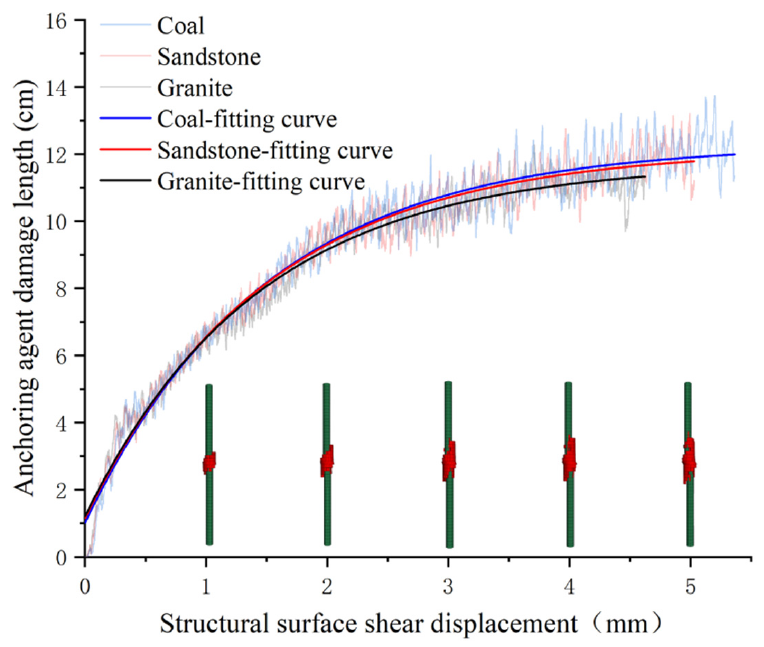
Figure 8. The change trend of the damage range of the anchoring agent under structural surface dislocation.